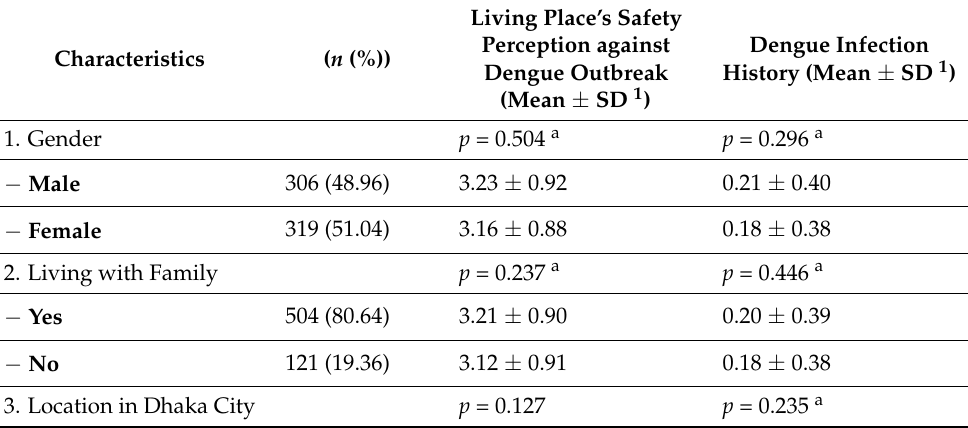
Table 1. Association of socio-demographic and academic information with living place’s safety and dengue infection history among university students of Dhaka city,